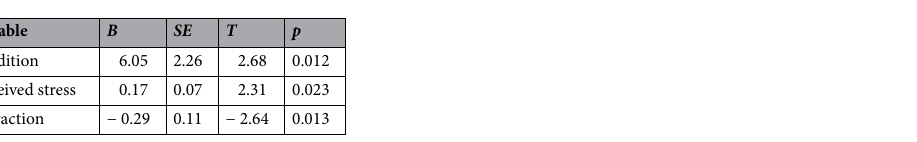
Figure 6. Associations between perceived chronic stress and post-acute stress perseverative errors for sAA responders ( a ; n = 7) and sAA nonresponders ( b ; n = 26); dotted lines indicate 95% confidence interval.